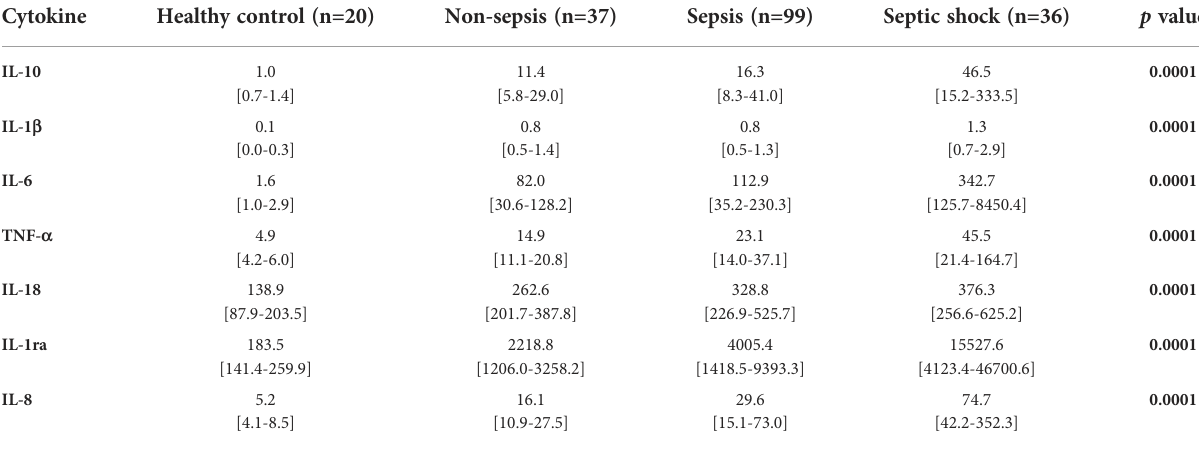
TABLE 3 Cytokine levels in healthy controls, non-sepsis, sepsis and septic shock patients on day 1 of admission to Emergency Department. Cytokine Healthy control (n=20)